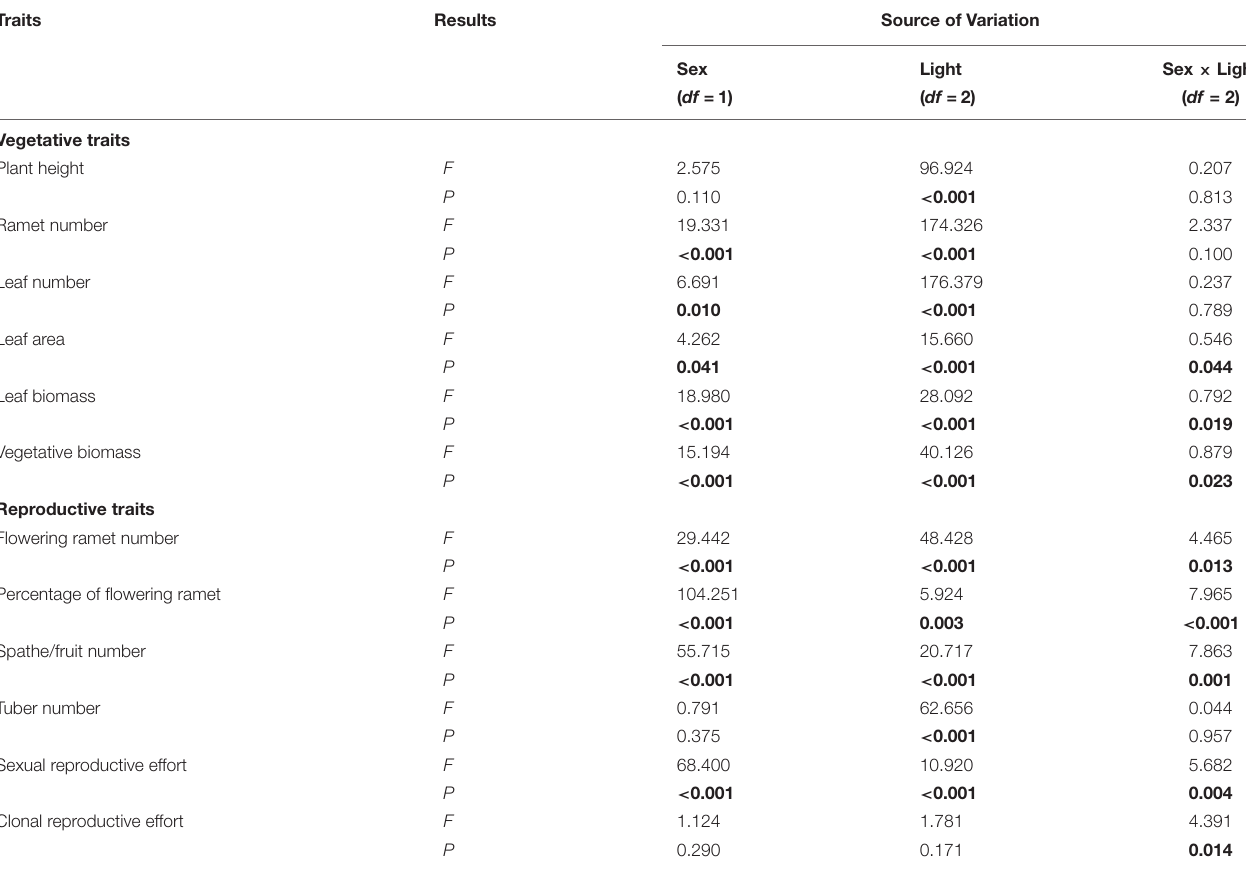
TABLE 1 | Results of the Restricted Maximum Likelihood (REML) linear mixed model analyses examining effects of sex and light treatment on traits of V. spinulosa . Traits